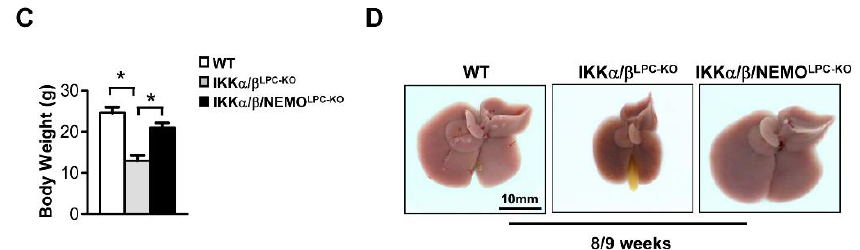
Figure 1. Additional deletion of NEMO in parenchymal liver cells rescues early lethality and growth retardation of IKK α / β LPC-KO mice. ( A ) Immunoblot analysis of IKK α , IKK β , NEMO and GAPDH (loading control) in whole liver-protein extracts from male wild type (WT), IKK α / β LPC-KO and IKK α / β / NEMO LPC-KO mice with relative intensity ratios. ( B ) Kaplan-Meier curve showing spontaneous death of IKK α / β LPC-KO mice between 23 and 38 weeks of age. *** p < 0.001 (WT n = 116, IKK α / β LPC-KO n = 36, and IKK α / β / NEMO LPC-KO n = 41). ( C ) Body weight analysis of male WT, IKK α / β LPC-KO and IKK α / β / NEMO LPC-KO mice. * p < 0.05; (n = 4). Results are shown as mean, error bars indicate SEM. ( D ) Representative macroscopic pictures of male WT, IKK α / β LPC-KO , and IKK α / β / NEMO LPC-KO livers.